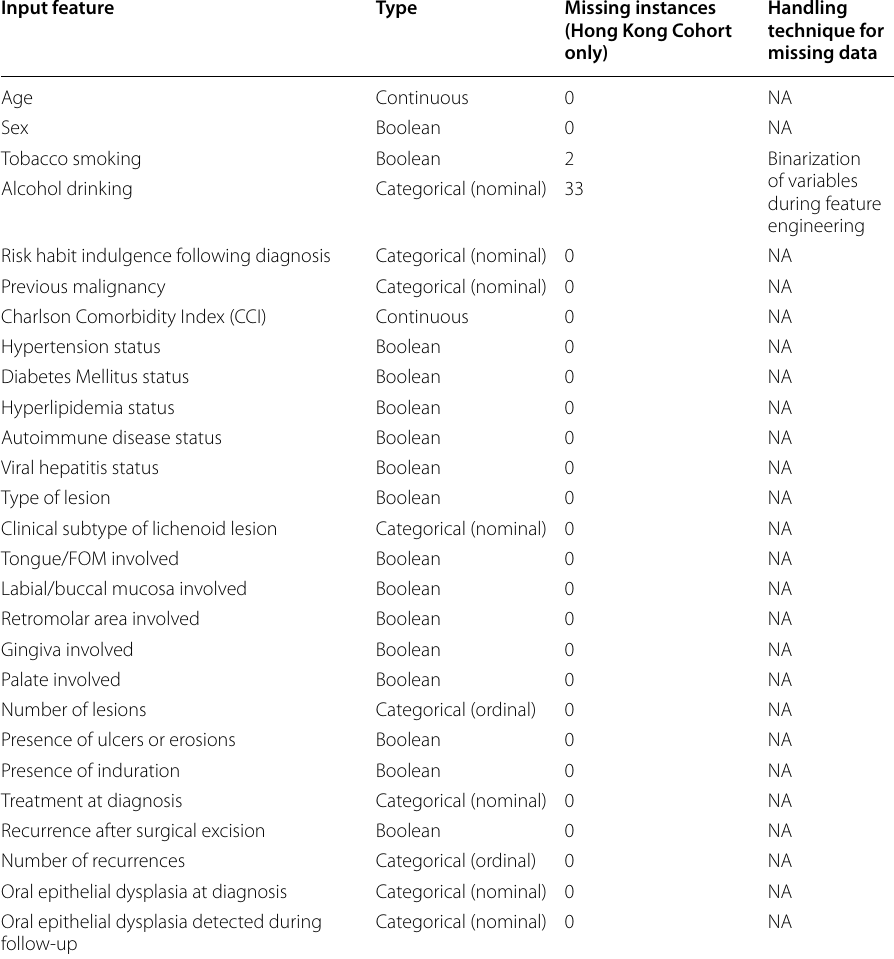
All predictors were used for modeling and the variables in bold were the predictors included in the 15 feature models in this study. Note that ‘Tobacco smoking’ and ‘Alcohol consumption’ were binarized into a single